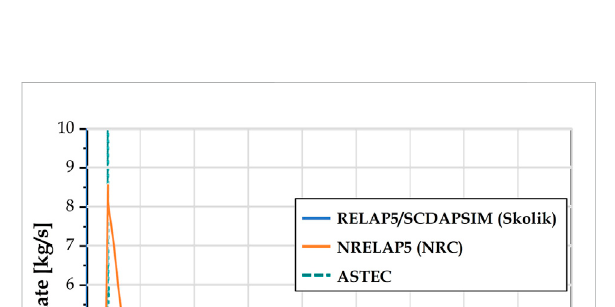
FIGURE 3 Turbine trip transient: Evolution of core thermal power after transient initiation. After reactor trip has been triggered, a 2.0-s delay is implemented before the actual sharp power reduction begins. Compared to the other two references, the thermal power in the fi rst 200 s in this work is set higher, before reaching the same decay heat level.